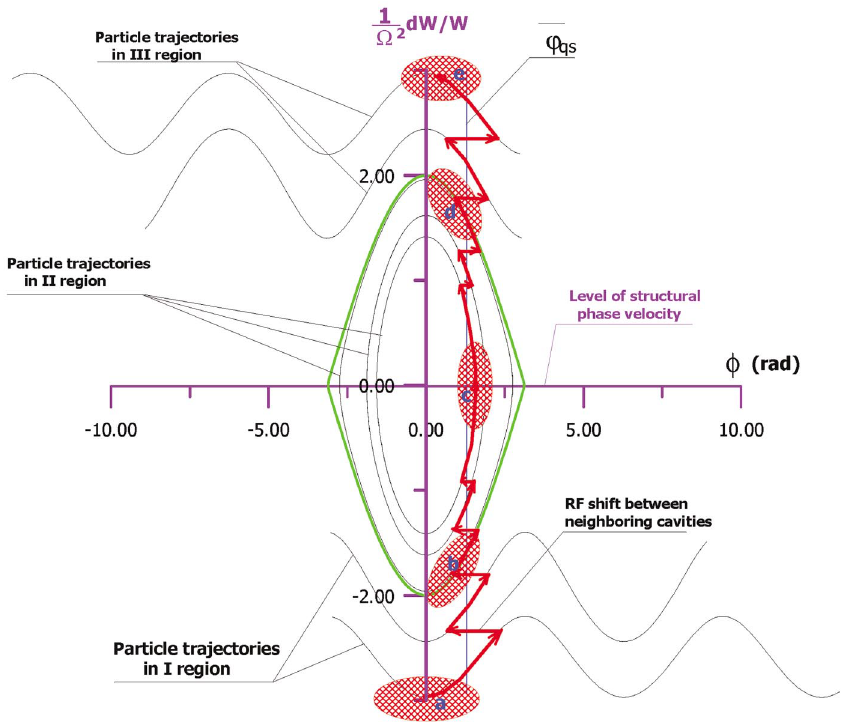
FIG. 1. (Color) Longitudinal motion in the stepped rf phase structure with one